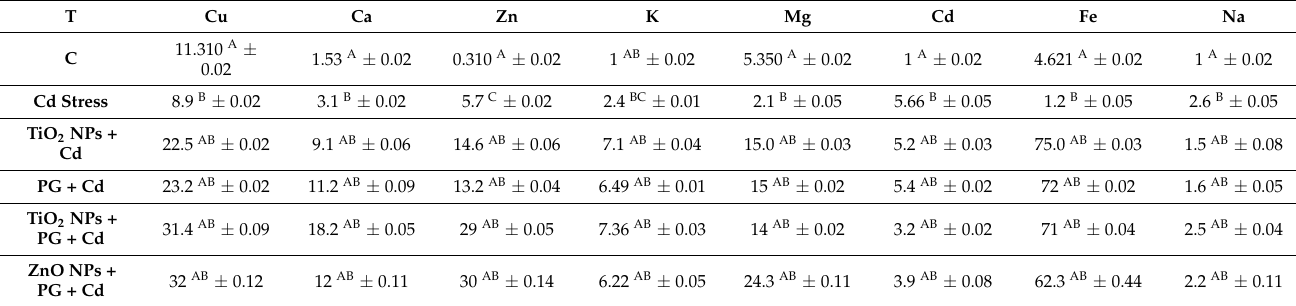
Table 5. Results of nutrient analysis of Cd stress, showing a decrease in the values of Fe, Mg, and Cu, as compared to control and treated plants. Values of Ca, Z, k, Cd, and Na were increased compared to controls but decreased in comparison to the treated